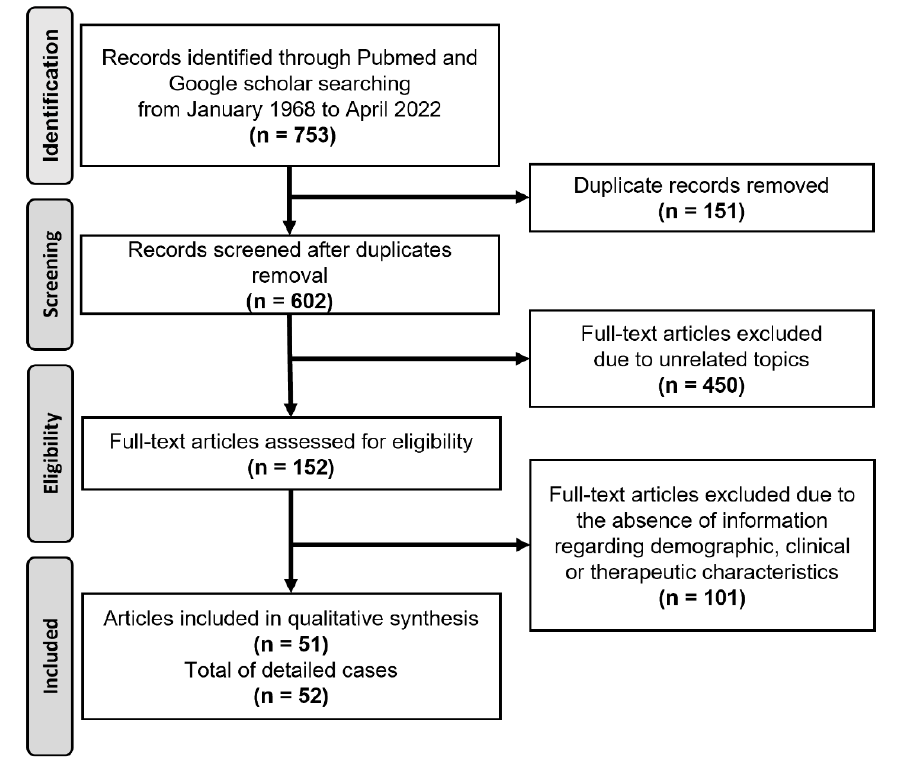
Figure 5. Flow chart of the literature review. Table 1. Demographics, clinical characteristics, and treatment outcomes of the patients with M. romeroi eumycetoma cases in the